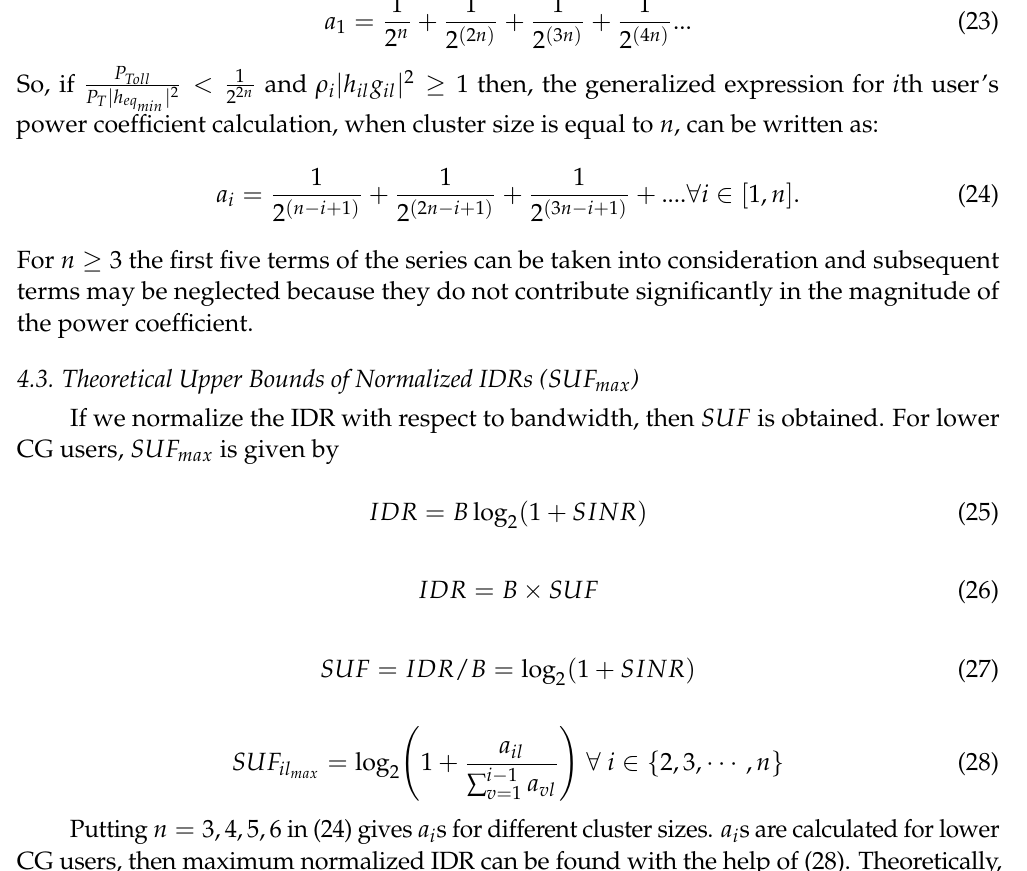
Table 1. Normalized IDR theoretical analysis in bits per second per Hertz for GP-based power allocation inside the RIS-assisted NOMA Downlink